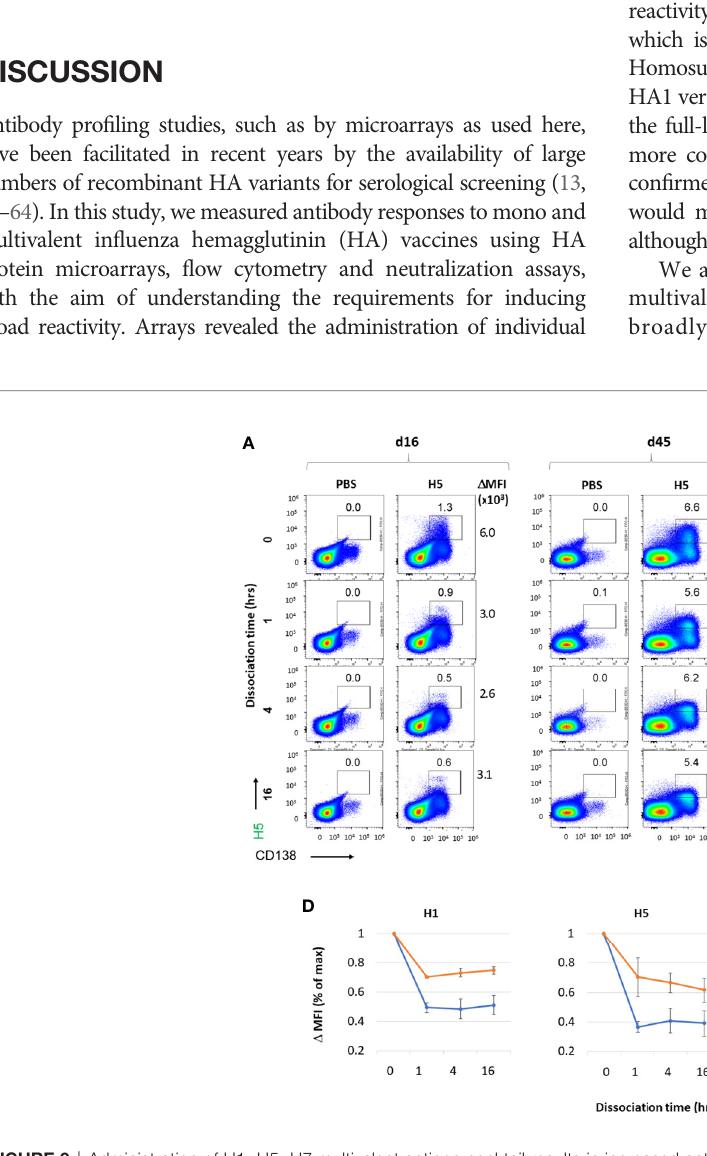
FIGURE 9 | Administration of H1+H5+H7 multivalent antigen cocktail results in increased antibody af fi nity to individual antigenic components over time. (A) Validation of af fi nity maturation assay using vaccine containing H5 alone (2.5 m g VN04 H5 trimer in IVAX-1) administered by s.c. route. Representative fl ow cytometry of plasma cells (x-axis) and H5(DyLight-488)-binding cells (y-axis) of unimmunized (PBS), or H5-immunized mice boosted on day 16 or 45 i.p. with the same formulation and splenocytes harvested 5 days later. Competition for binding with an excess of unlabeled H5 protein was performed for 0, 1, 14 and 16 hrs. This demonstrates speci fi city of H5 binding, as well as providing a measure of antibody af fi nity for H5 antigen according to rate of dissociation. (B) The % of H5-speci fi c plasma cells, and (C) D MFI, de fi ned as the difference in mean fl uorescence intensity between the antigen-positive population (rectangular gate) and the antigen negative population (not shown). The experiment was performed independently on two mice at each time point. (D) D MFI of plasma cells positive for H1(DyLight-405), H5(DyLight-488), and H7(DyLight-650) in mice administered a trivalent formulation (2.5 m g each of H1, H5 and H7 in IVAX-1 adjuvant) via s.c route. Competition for binding with an excess of unlabeled H1, H5 or H7 was performed for 0, 1, 4 and 16 hrs. nd, not